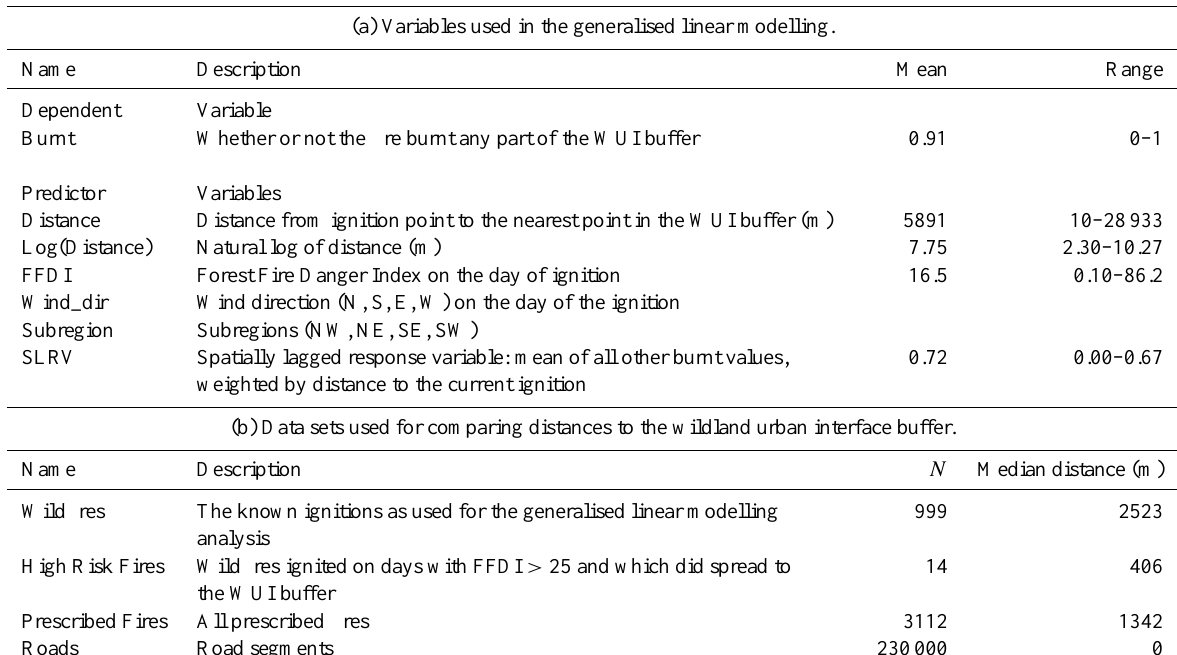
Table 1. Variables and data sets used in the analysis. (a) Variables used in the generalised linear modelling.